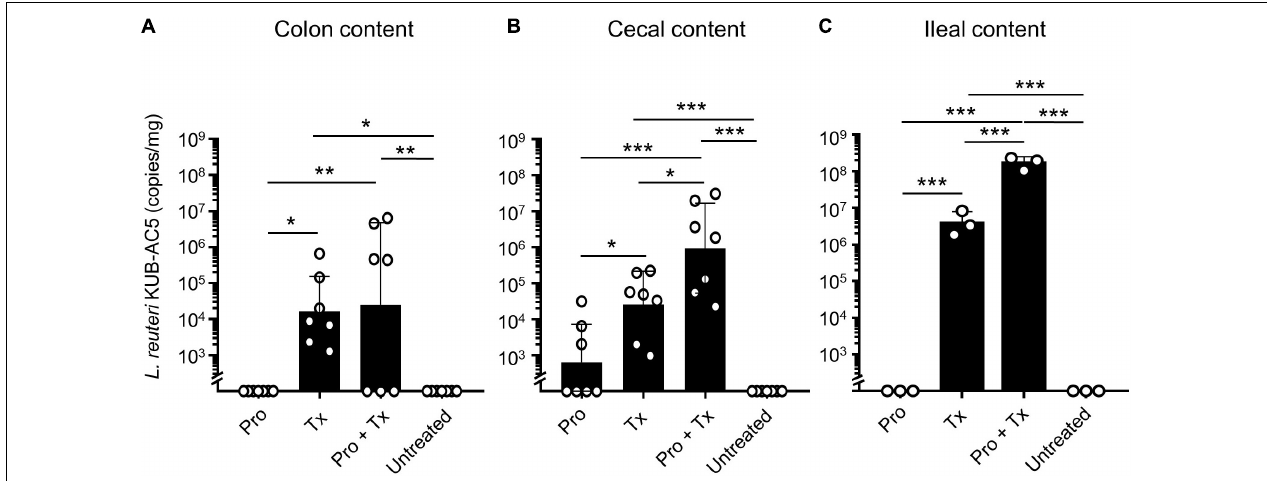
FIGURE 3 | Detectable amounts of L. reuteri KUB-AC5 in mouse gut contents. At day 4 post infection, mouse gut contents in colon, cecum, and ileum were collected and quantified for AC5 by qPCR. The copies/mg of AC5 in each gut content was calculated and depicted. Bars represent geometric means ± SD. * P < 0.05, ** P < 0.01, and *** P < 0.001 compared to all other